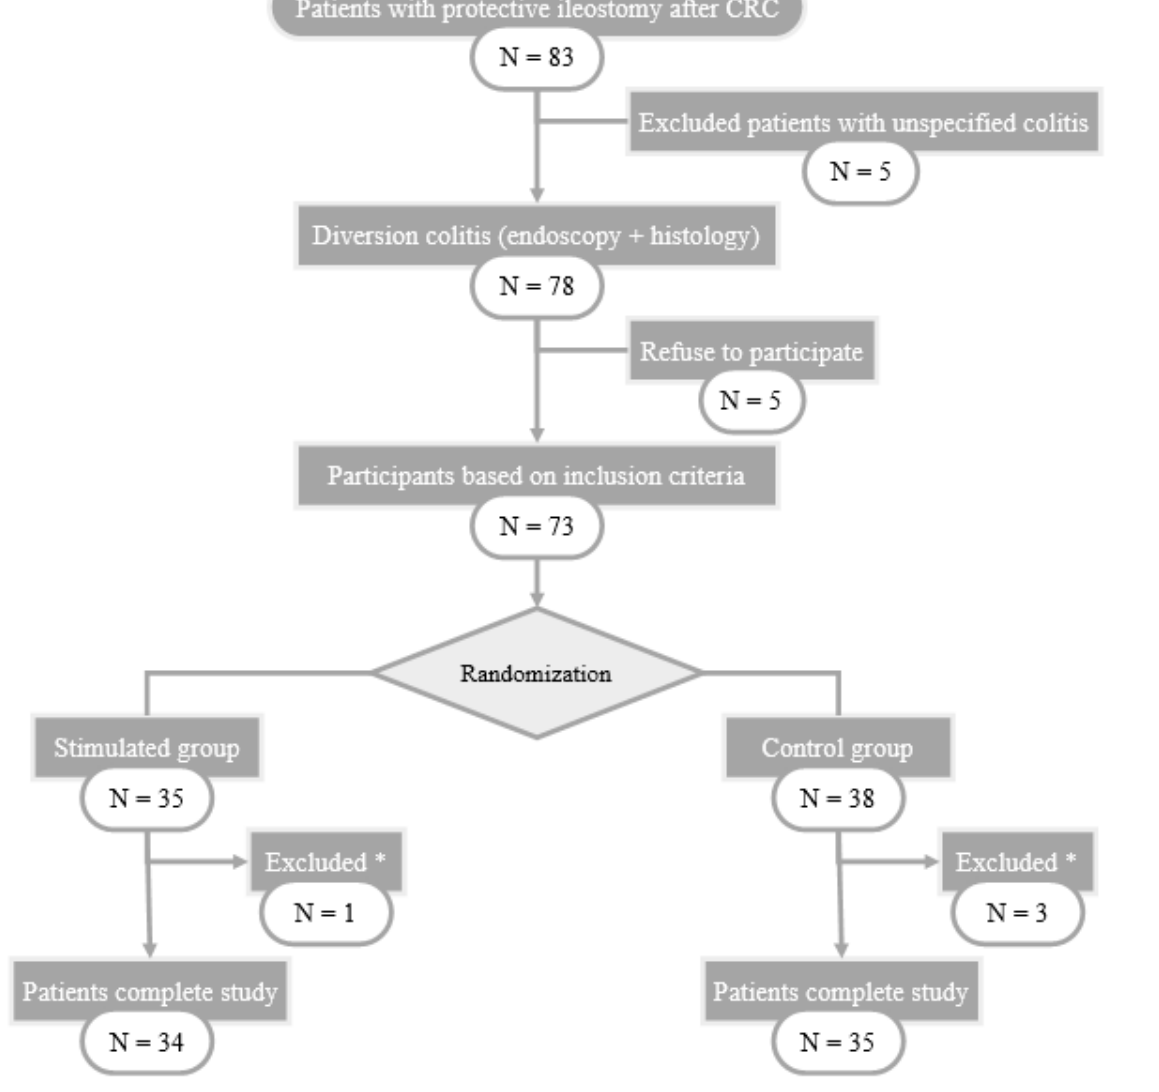
Figure 1. Flow-chart of patient selection. CRC: Colorectal Cancer; *: excluded patients with anastomotic leak.